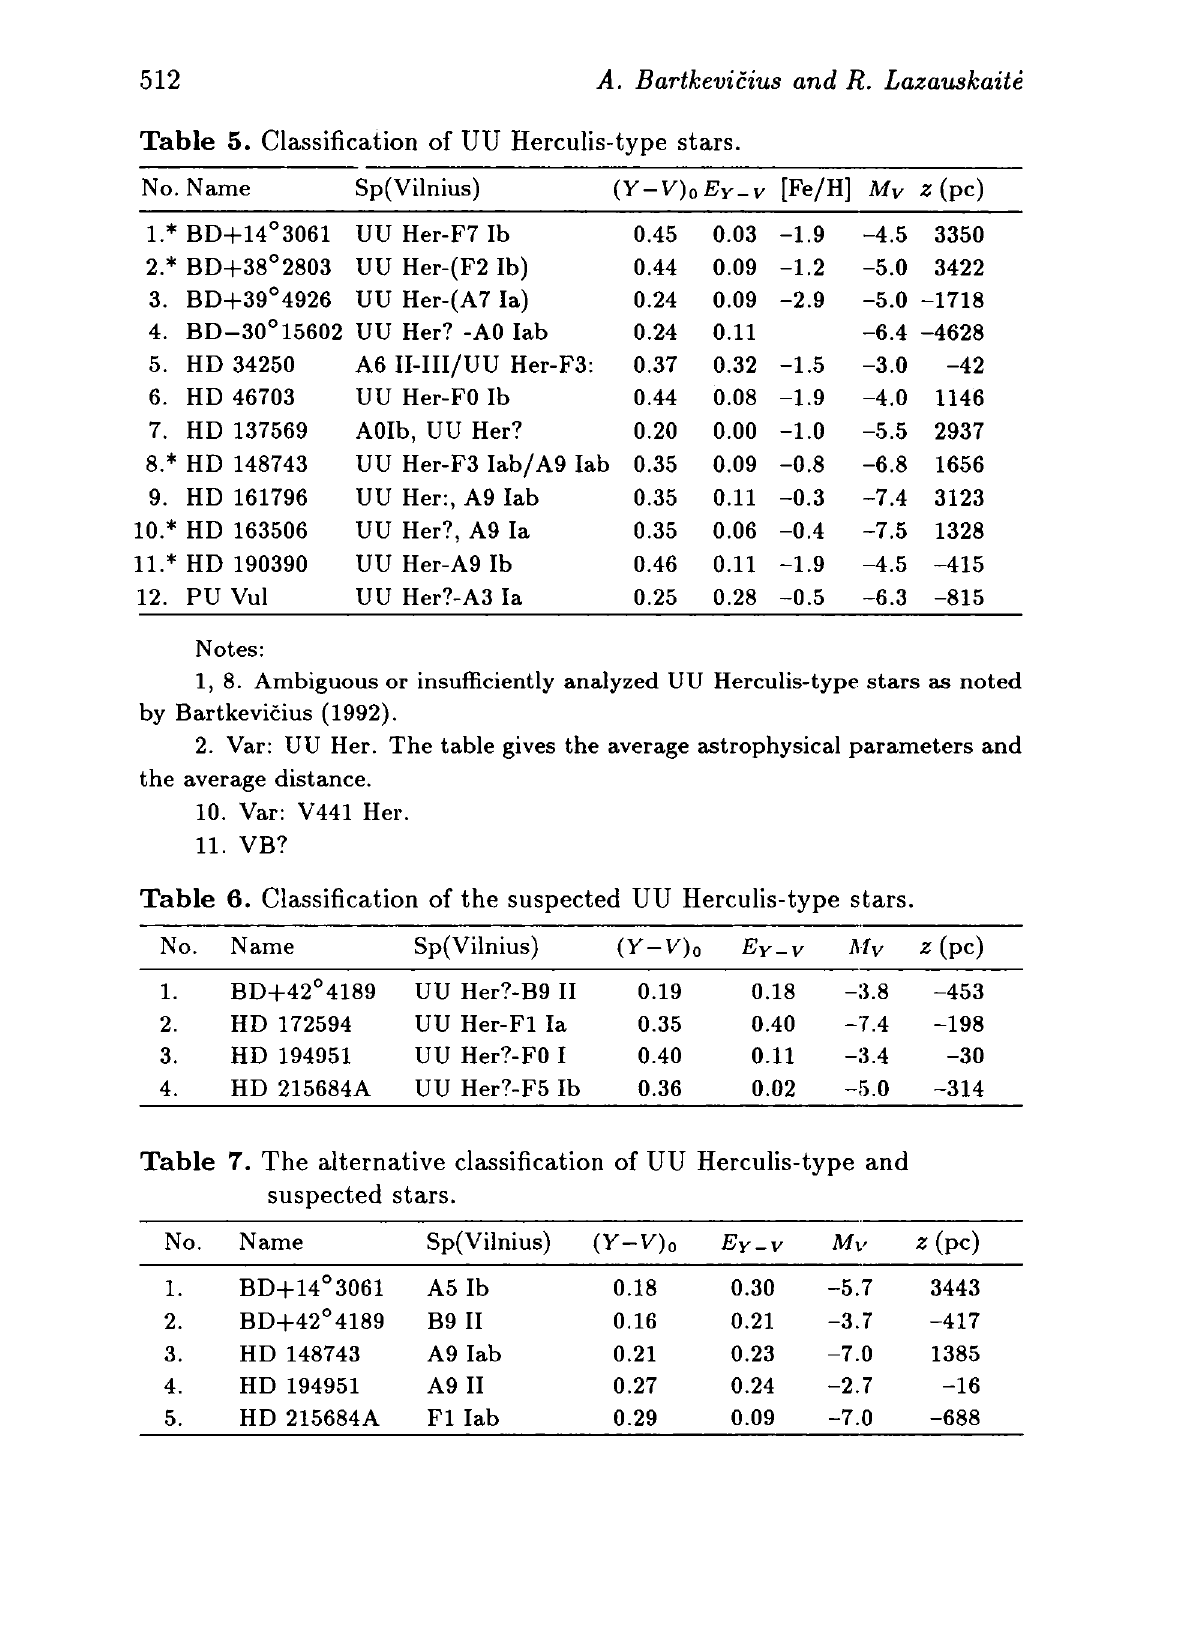
Table 5. Classification of UU Herculis-type stars.